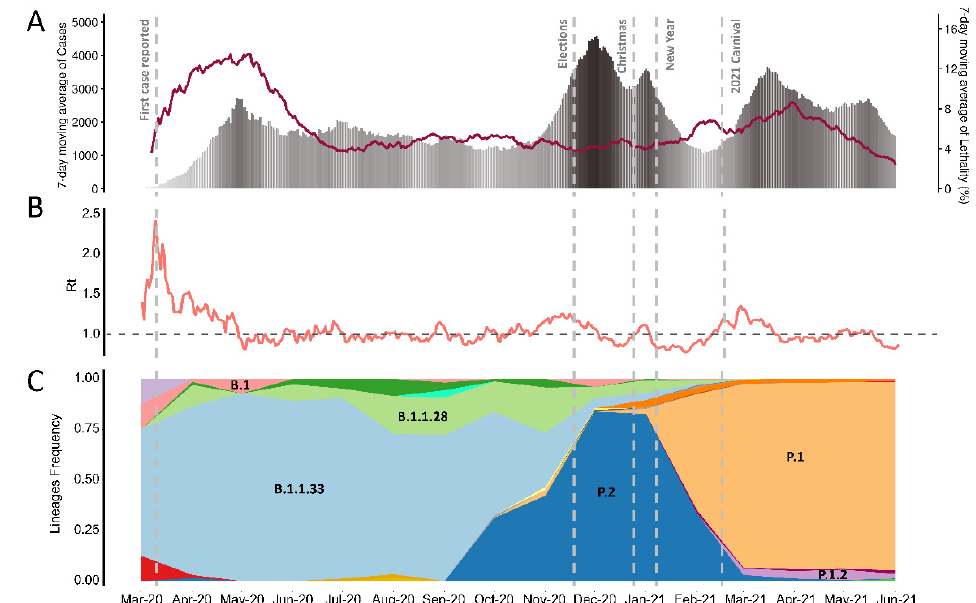
Figure 1. Epidemiological findings and successive lineage replacement during SARS-CoV-2 epidemic in the state of Rio de Janeiro. ( A ) The 7-days moving average of cases and lethality reported from 1 March 2020 to 6 June 2021. Dashed lines indicate the first reported case, elections, Christmas, new year, and carnival 2021, respectively. The degree in grayscale shows the increases in the number of cases in each phase. ( B ) Estimation of the real-time reproduction number (Rt). ( C ) Temporal distribution of the relative frequencies of SARS-CoV-2 lineages in the state of Rio de Janeiro. We only highlighted the VoC and VoI variants circulating in the state.